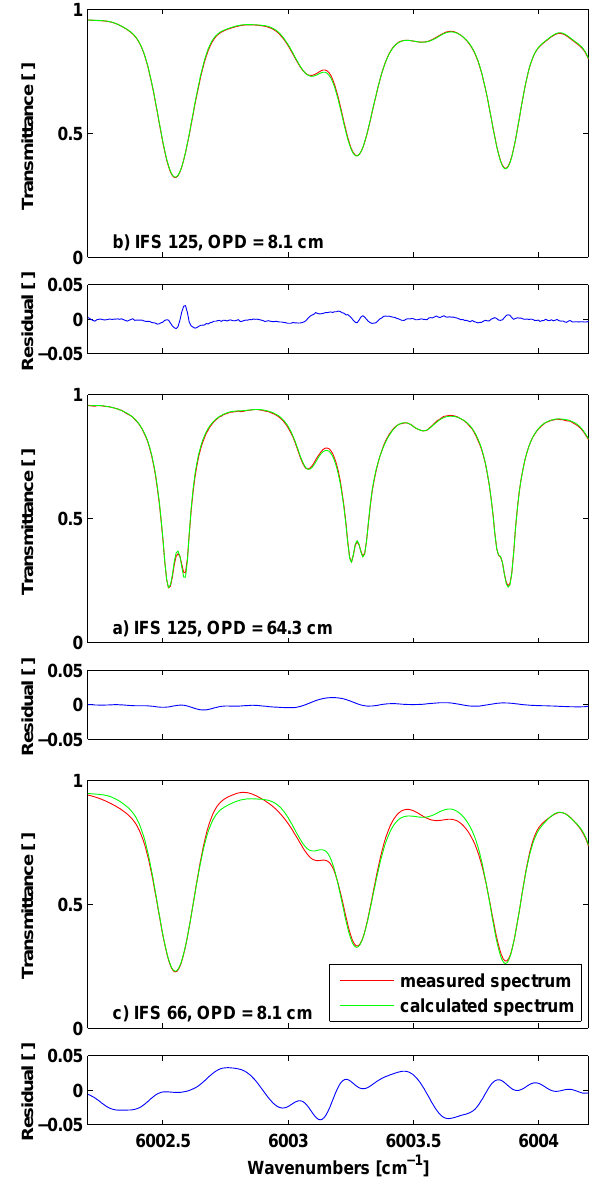
Fig. 3. Small part of a measured and simulated spectrum in the region of CH 4 . Panel (a) shows the high resolution spectrum of the IFS125HR at a resolution of 0.014cm − 1 (OPD=64 cm), (b) is based on the same measurement, but the interferogram has been truncated to a resolution of 0.11cm − 1 (OPD=8.1cm), and (c) shows a spectrum measured by the IFS66 at a resolution of 0.11cm − 1